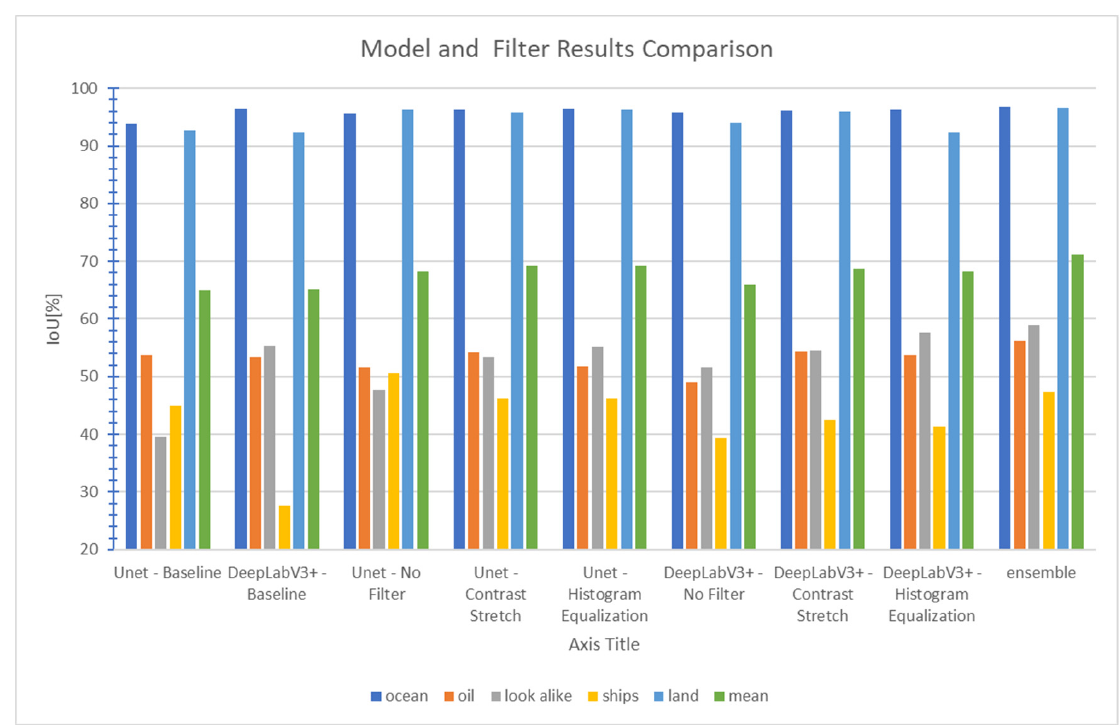
Figure 7. Comparison of model and filter final results .